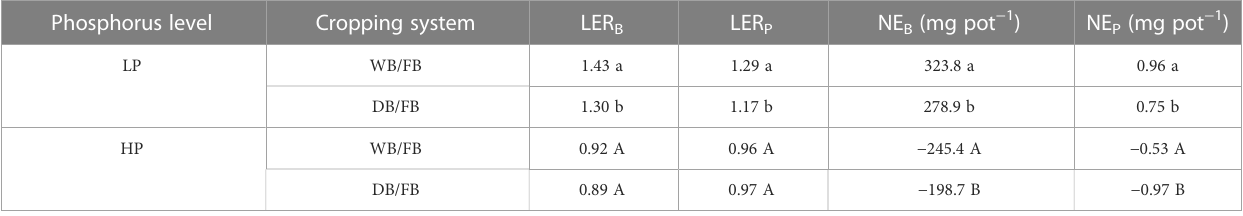
Values represent the means of three replicates. For a given P fertilizer level, different letters indicate a signi fi cant difference between WB/FB and DB/FB (p< 0.05). LER B , LER based on plant biomass; LER P , LERbased on P uptake; NE B , NE based on biomass; NE P , NE based on P uptake; LP, lowP; HP, high P; WB, wild barley; DB, domesticated barley; FB, faba